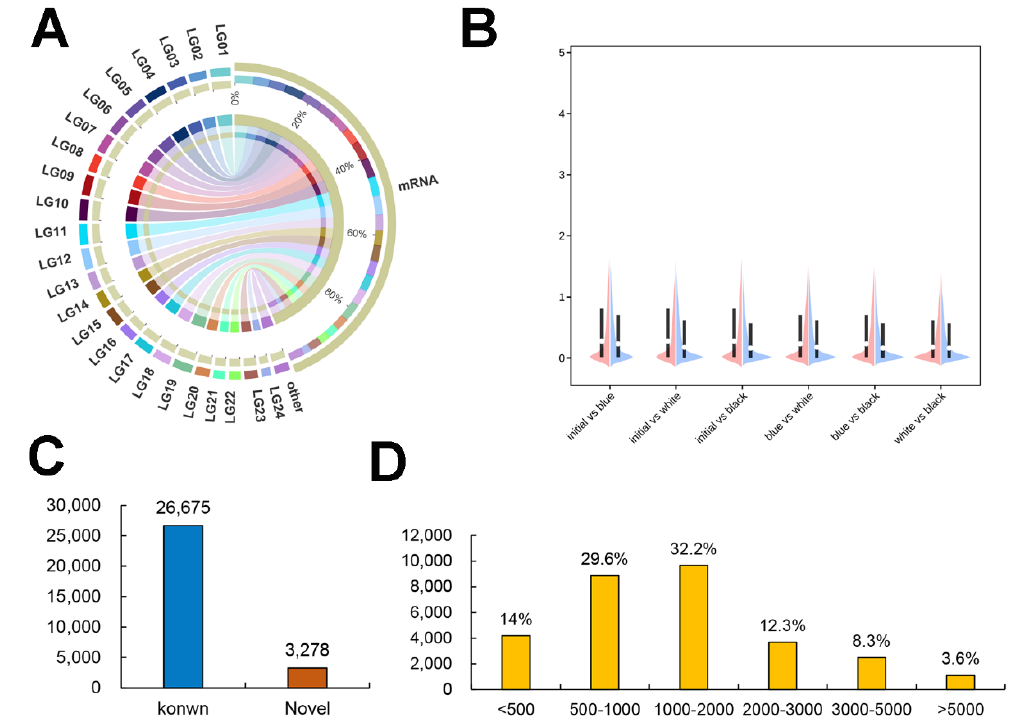
Figure 2. Characterization of skin mRNAs in different groups. ( A ) The distribution of mRNA on the chromosomes. ( B ) Violin plot of mRNA expression level in different groups. ( C ) Number of mRNAs. ( D ) Length of the mRNAs.